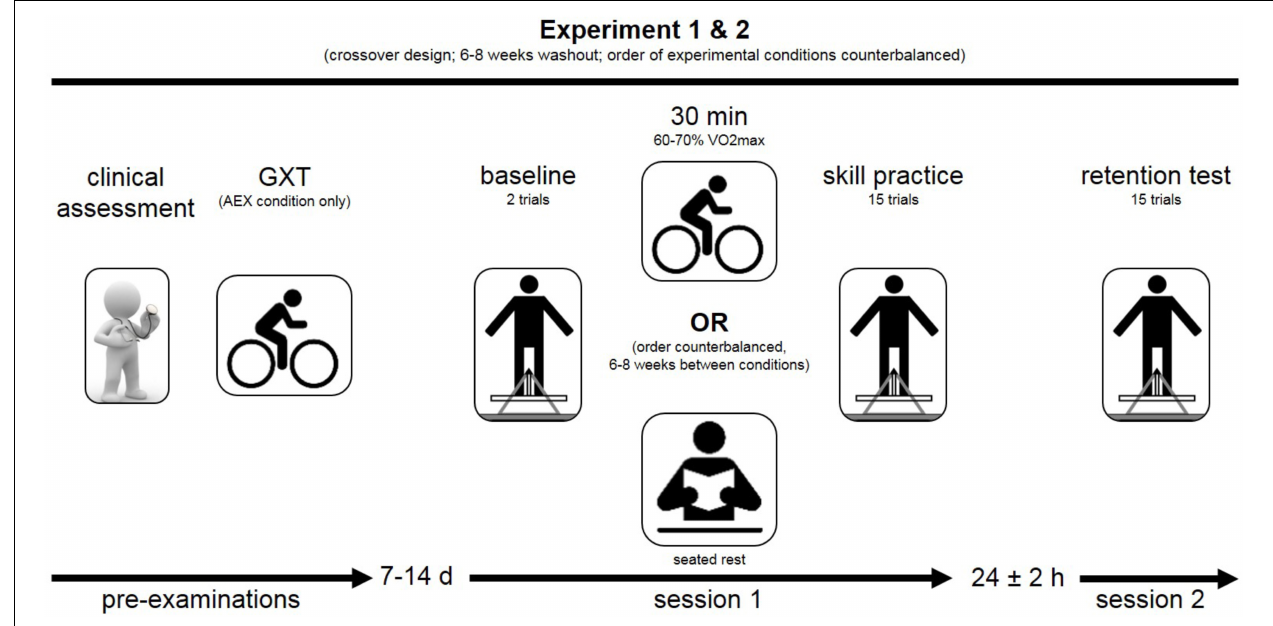
FIGURE 1 | Schematic overview of the experimental design. Figure illustrates the experimental flow. Pre-examinations included a clinical assessment of the patients’ neurological and cognitive status. Subsequently, patients participated in two separate experiments, including either the experimental (cycling) or control condition (rest). The order of experiments was counter-balanced and separated by 6–8 weeks (cross-over design). Each of the two experiments included an acquisition phase (session 1), followed by a retention test (session 2) 24 h later. Cardiac screening included a graded exercise test (GXT) and was performed prior to the experiment including the cycling condition